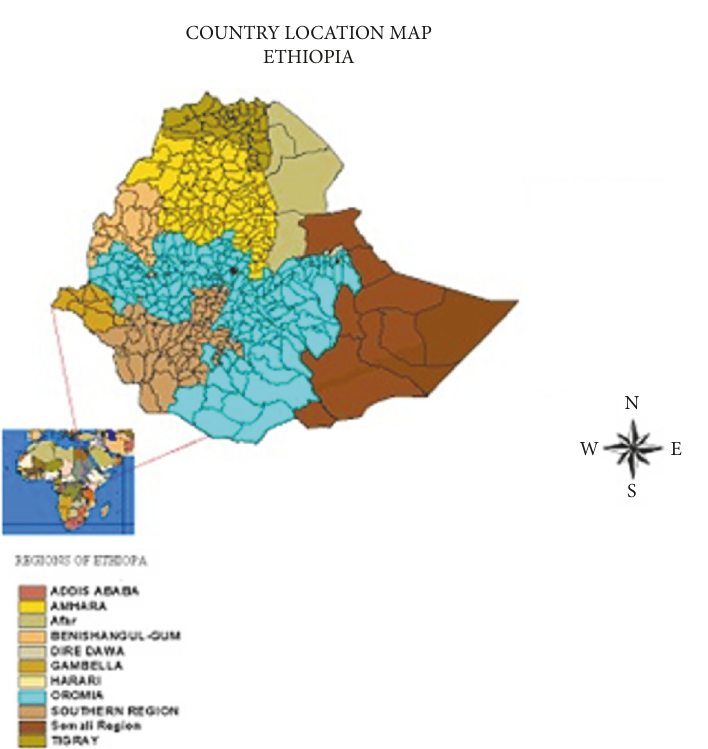
Figure 1: Location map of Ethiopia. Source Ministry of Agriculture,